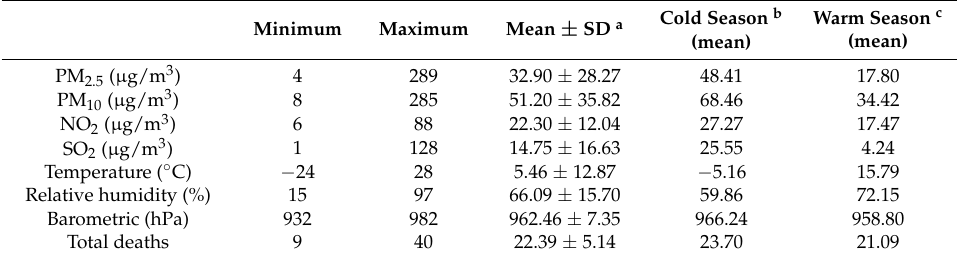
Table 2. Levels of daily air pollutants and deaths from cardio-cerebrovascular disease in Yanbian, China.